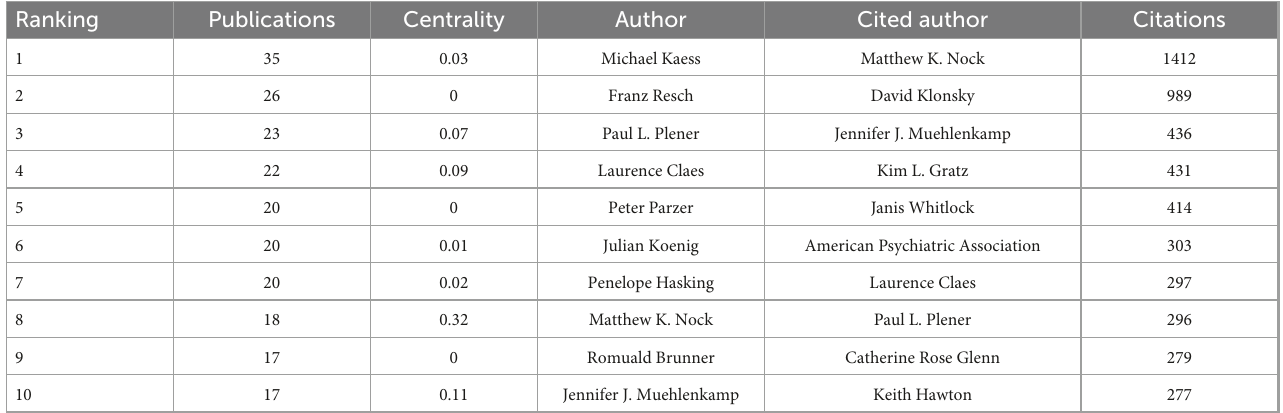
TABLE 5 The top 10 authors and cited authors of non-suicidal self-injury (NSSI).